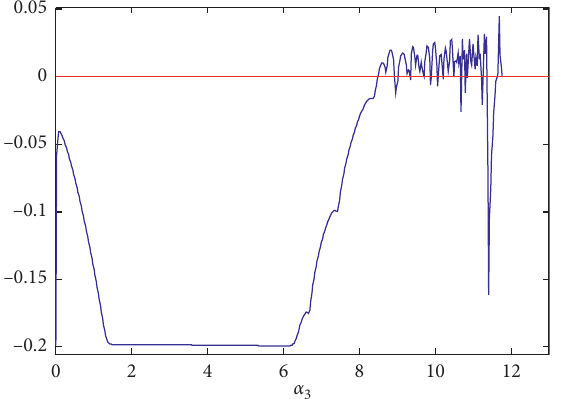
Figure 6: Maximal Lyapunov exponent for α